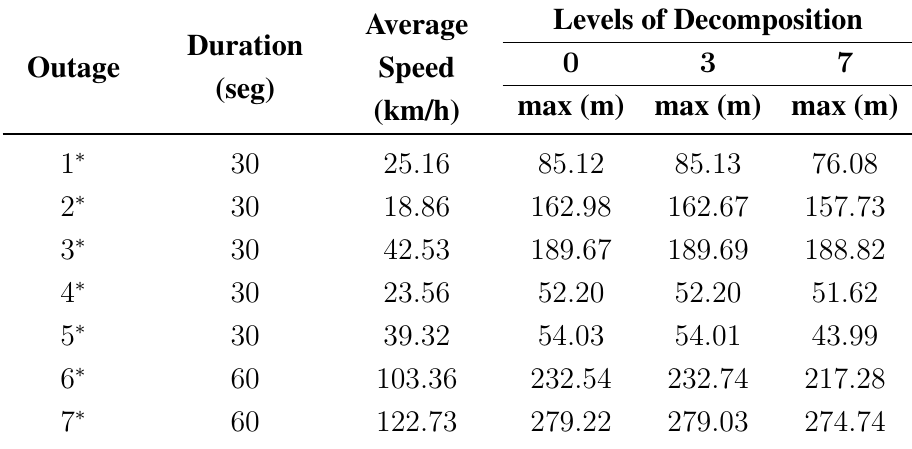
Table 6. Maximum horizontal position error during GPS outages before and after applying wavelet de-noising.